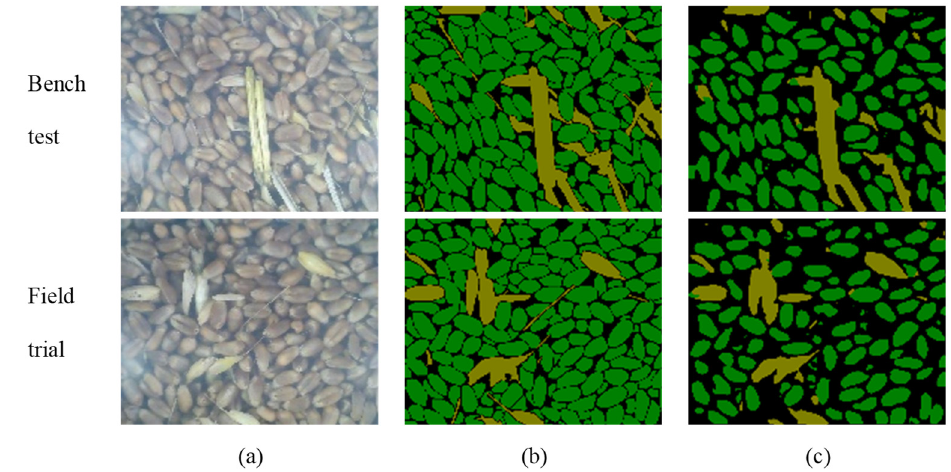
Figure 7. ResNet-50 recognizes segmentation effects online. ( a ) Original image; ( b ) manual annotation image; ( c ) device recognition segmentation image.